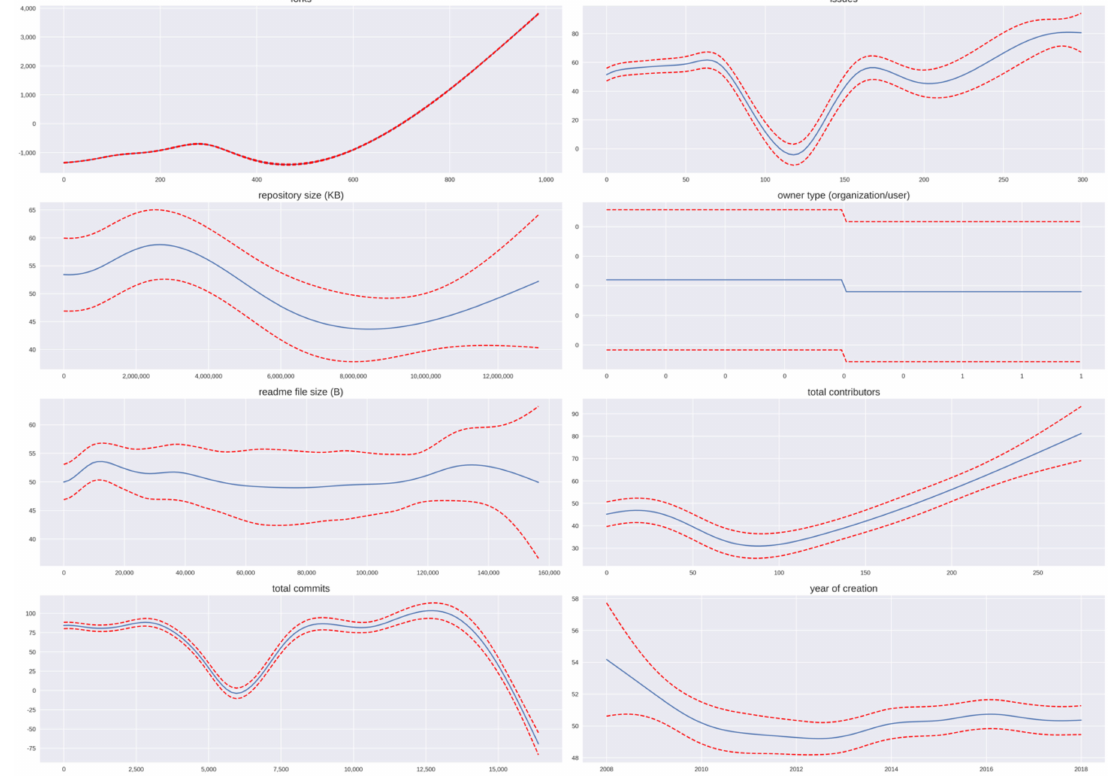
Figure 3. Partial dependency plots showing the relationships between the predictors (forks, open issues, repository size, owner type, README file size, total contributors, total commits, year of creation) and the number of stars on GitHub